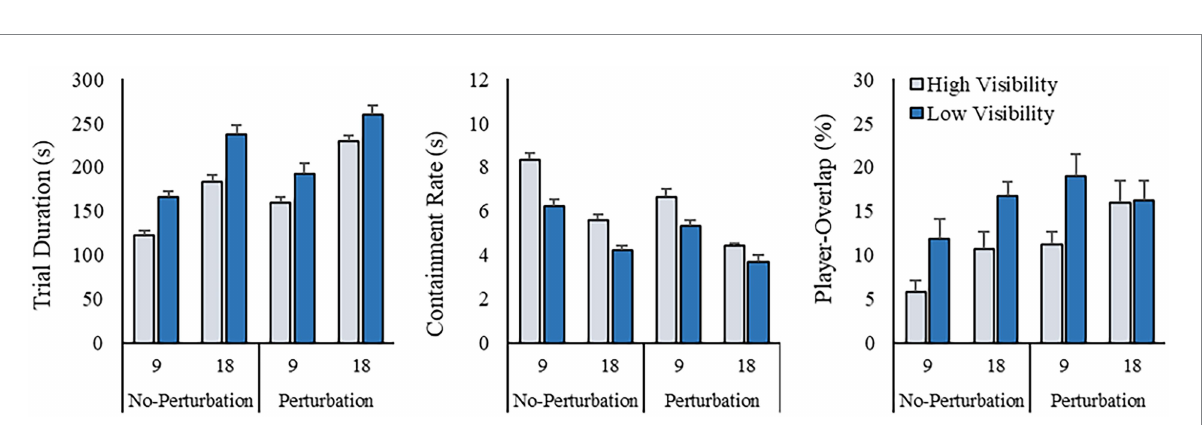
FIGURE 6 Summary of team performance and division of labor measures. Results are reported as a function of the different manipulations (target number, visibility, and task perturbation). Error bars represent the standard error of the mean.